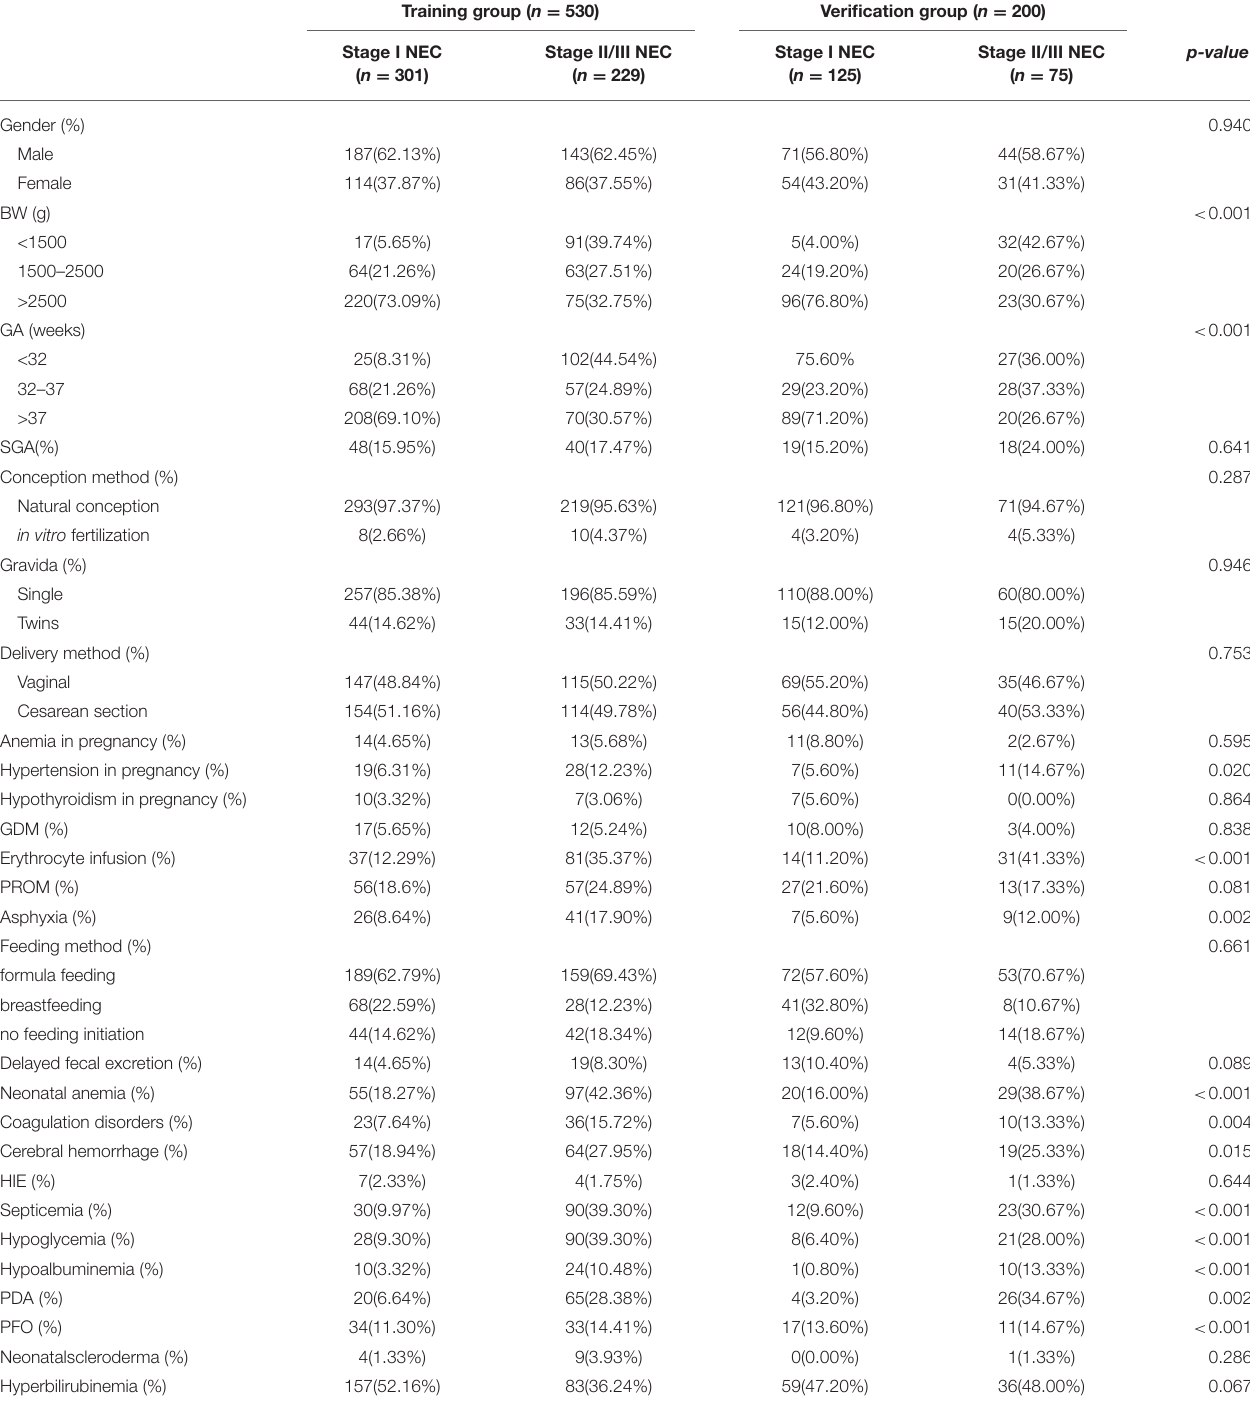
TABLE 1 | Characteristics of the included